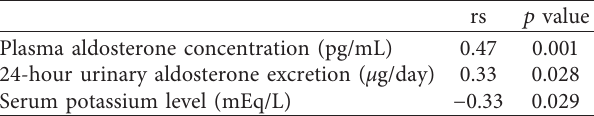
Table 2: Single regression analyses with CYP11B2 expression multiplied by tumor